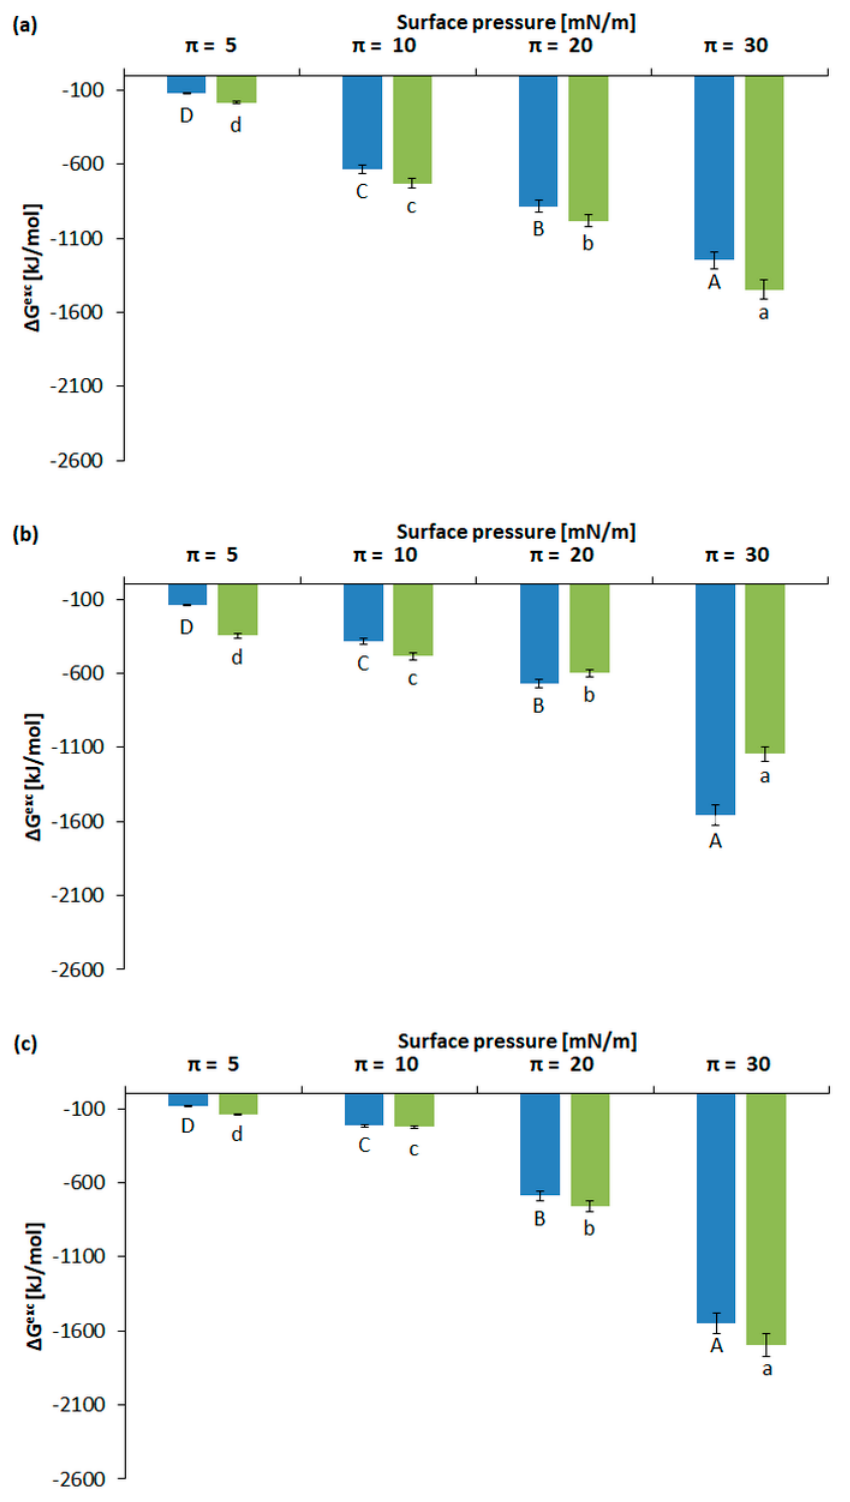
Figure 5. The changes of excess free energy of mixing ( ∆ G exc ) for the HL-60 model membrane (green color) and U-937 model membrane (blue color) ( a ) without 3FTx treatment and with ( b ) 10 ng/mL 3FTx and ( c ) 40 ng/mL 3FTx at four surface pressures: 5, 10, 20, and 30 mN/m. Values represent the average ± SD (n = 5).Significant differences between surface pressures were marked: within the U-937 cell line they were marked by uppercase letters and for the HL-60 cell line with lowercase